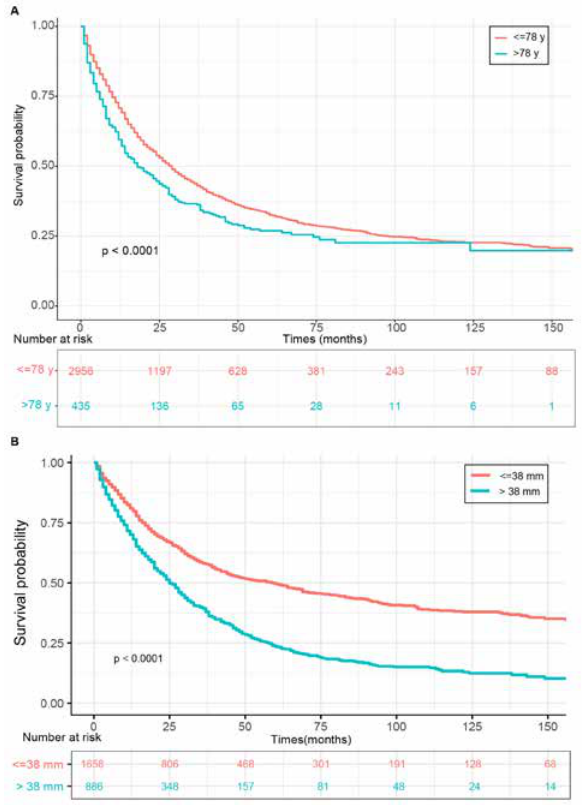
Figure 4: OS for primary pulmonary PA patients classified by (A) age. (B) tumor size. Abbreviations: OS, overall survival; PA, papillary adenocarcinoma.